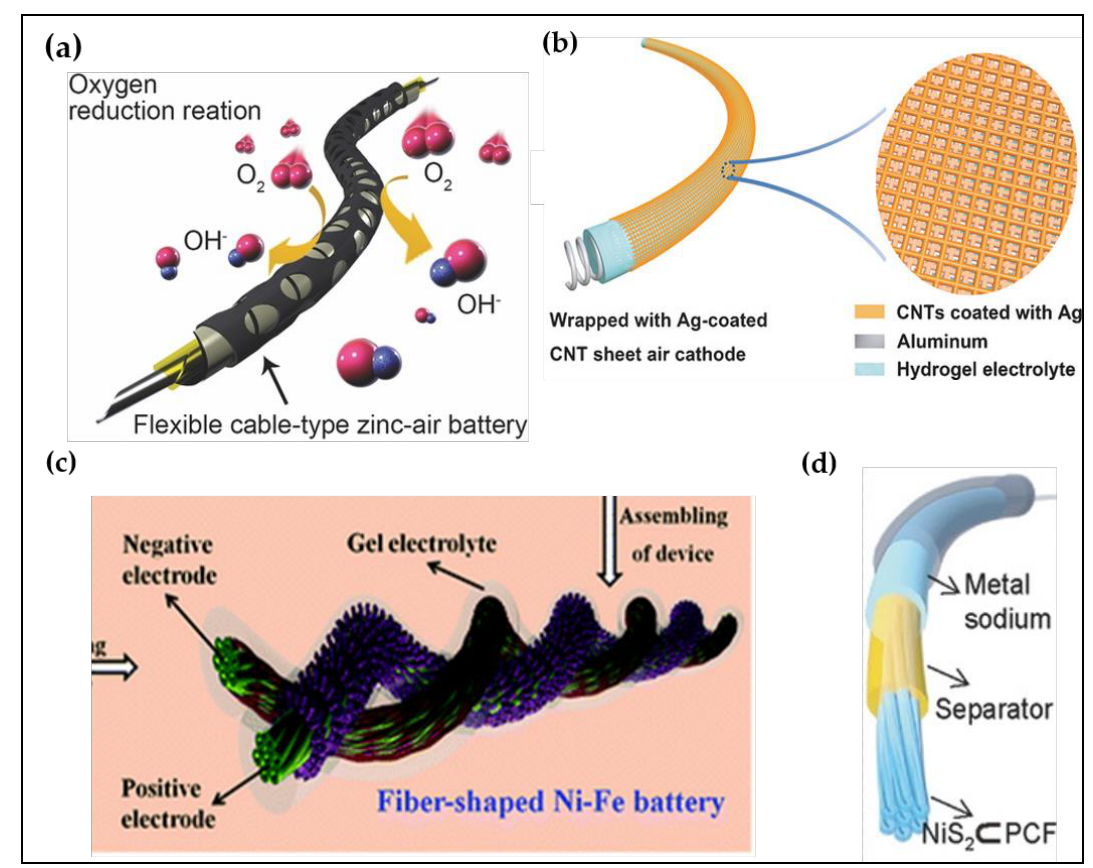
Figure 7. Schematic illustration of representative fiber-based non-lithium-ion batteries. ( a ) Zn-based metal-air battery fiber. Reproduced with permission from [142], Copyright (2015), Wiley. ( b ) Al-based metal-air battery fiber. Reproduced with permission from [143], Copyright (2016), Wiley. ( c ) Ni-Fe based Ni-metal battery fiber. Reproduced with permission from [144], Copyright (2019), Royal Society of Chemistry. ( d ) Sodium-based metal-air battery fiber. Reproduced with permission from [145], Copyright (2018), Wiley.